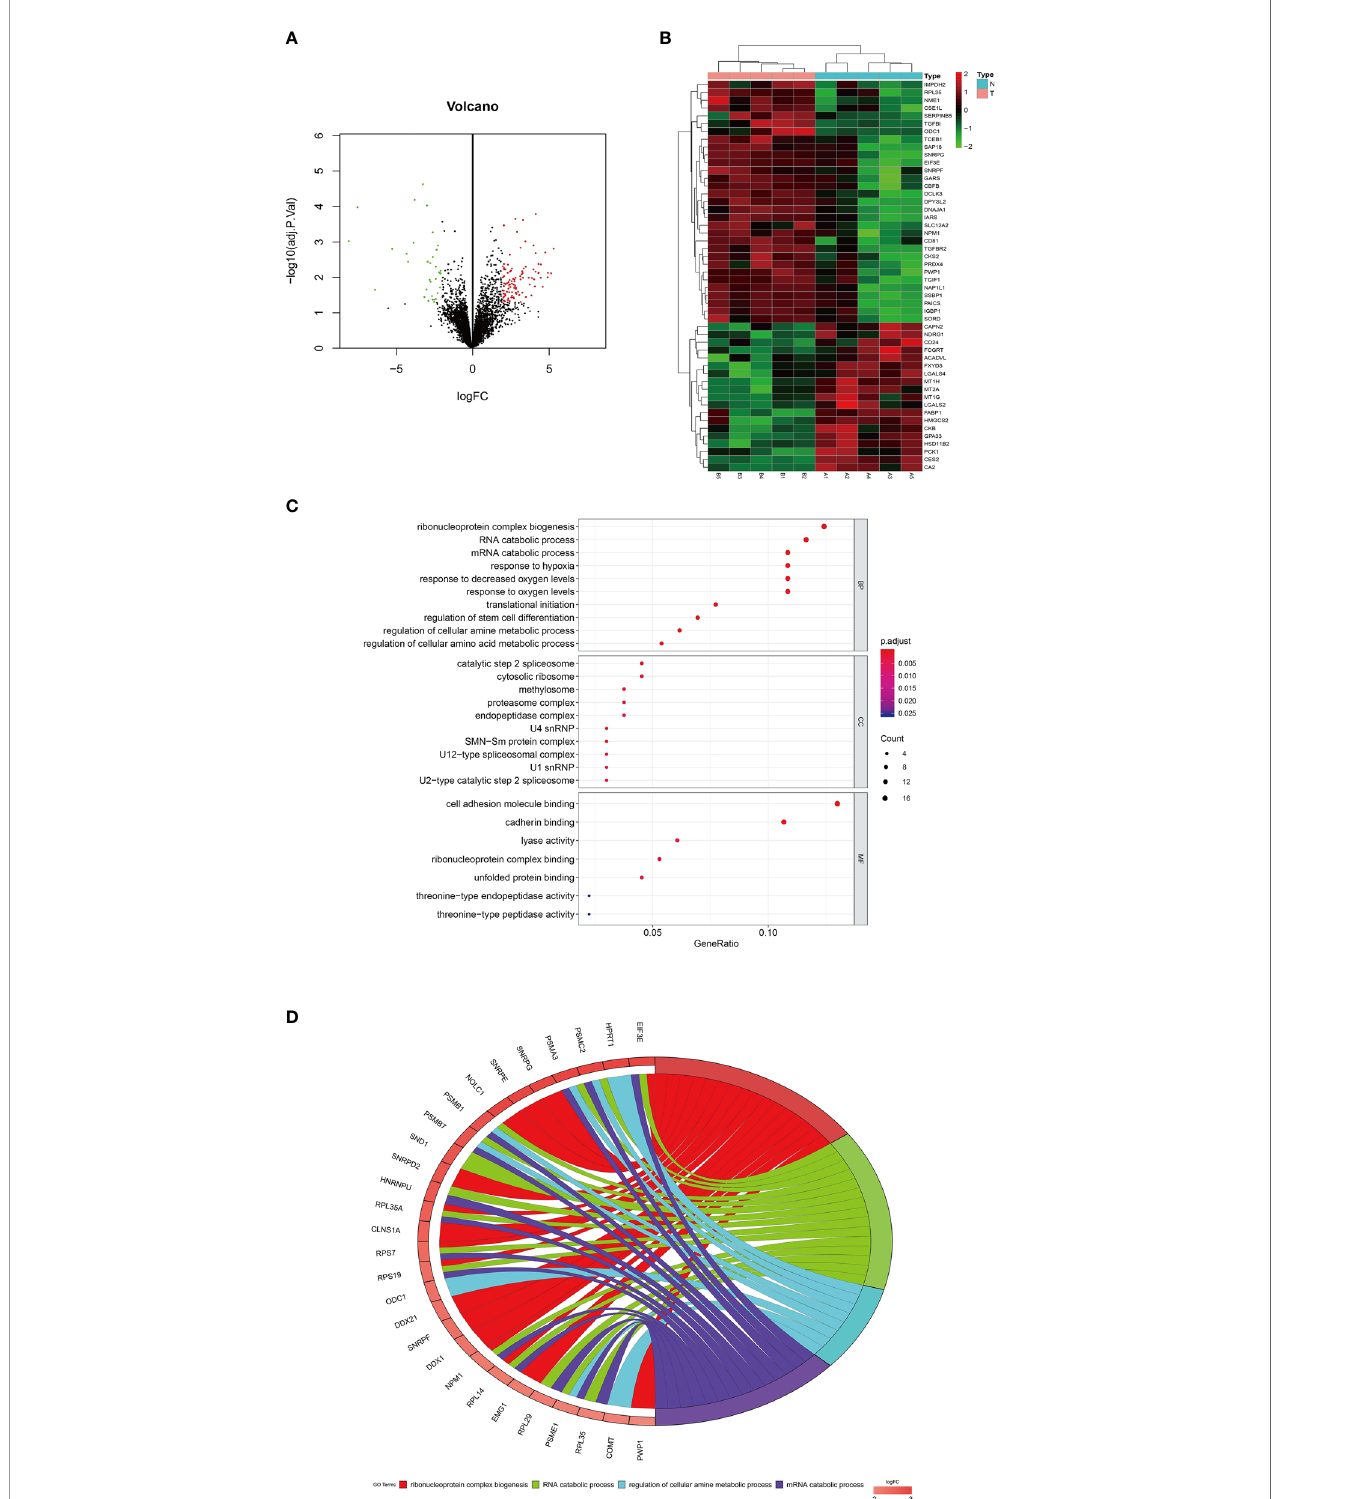
FIGURE 5 | Dysregulated mRNAs by microarray analysis using colon tissues and GO analysis. (A) Volcano plot of the mRNAs. The red and green points represent differently expressed mRNAs (logFC > 2 or < − 2 and adjust P value < 0.05). (B) Heatmap of differently expressed mRNAs (top 50). (C) Bubble and (D) circle plots by GO analysis with all the dysregulated genes. FC, fold change; GO, gene ontology; BP, biological processes; MF, molecular function; CC, cellular